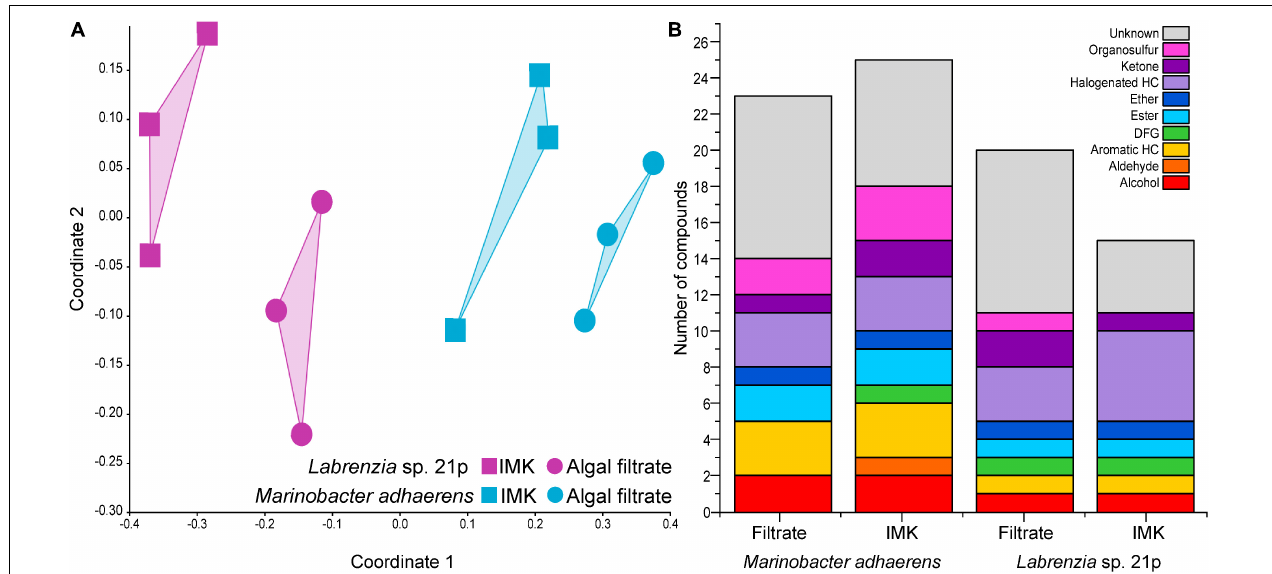
FIGURE 1 | (A) Non-metric multidimensional scaling (nMDS; Bray–Curtis Similarity; Stress = 0.1055) analysis on the volatilomes of Labrenzia sp. 21p and Marinobacter adhaerens incubated either IMK medium or algal filtrate. (B) Chemical functional groups present in Labrenzia sp. 21p and Marinobacter adhaerens incubated in either IMK medium or algal filtrate (total number of volatile compounds present in at least two out of three replicates). HC, hydrocarbon; DFG, diverse functional